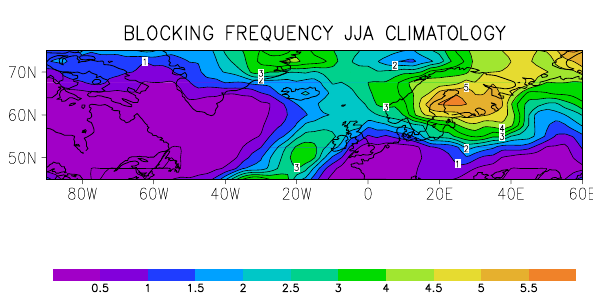
Fig. 12. Upper atmospheric circulation (500mb) for the blocking event from 26 June 1972. Colour (Z500), vector (wind). Units are m and ms − 1 .